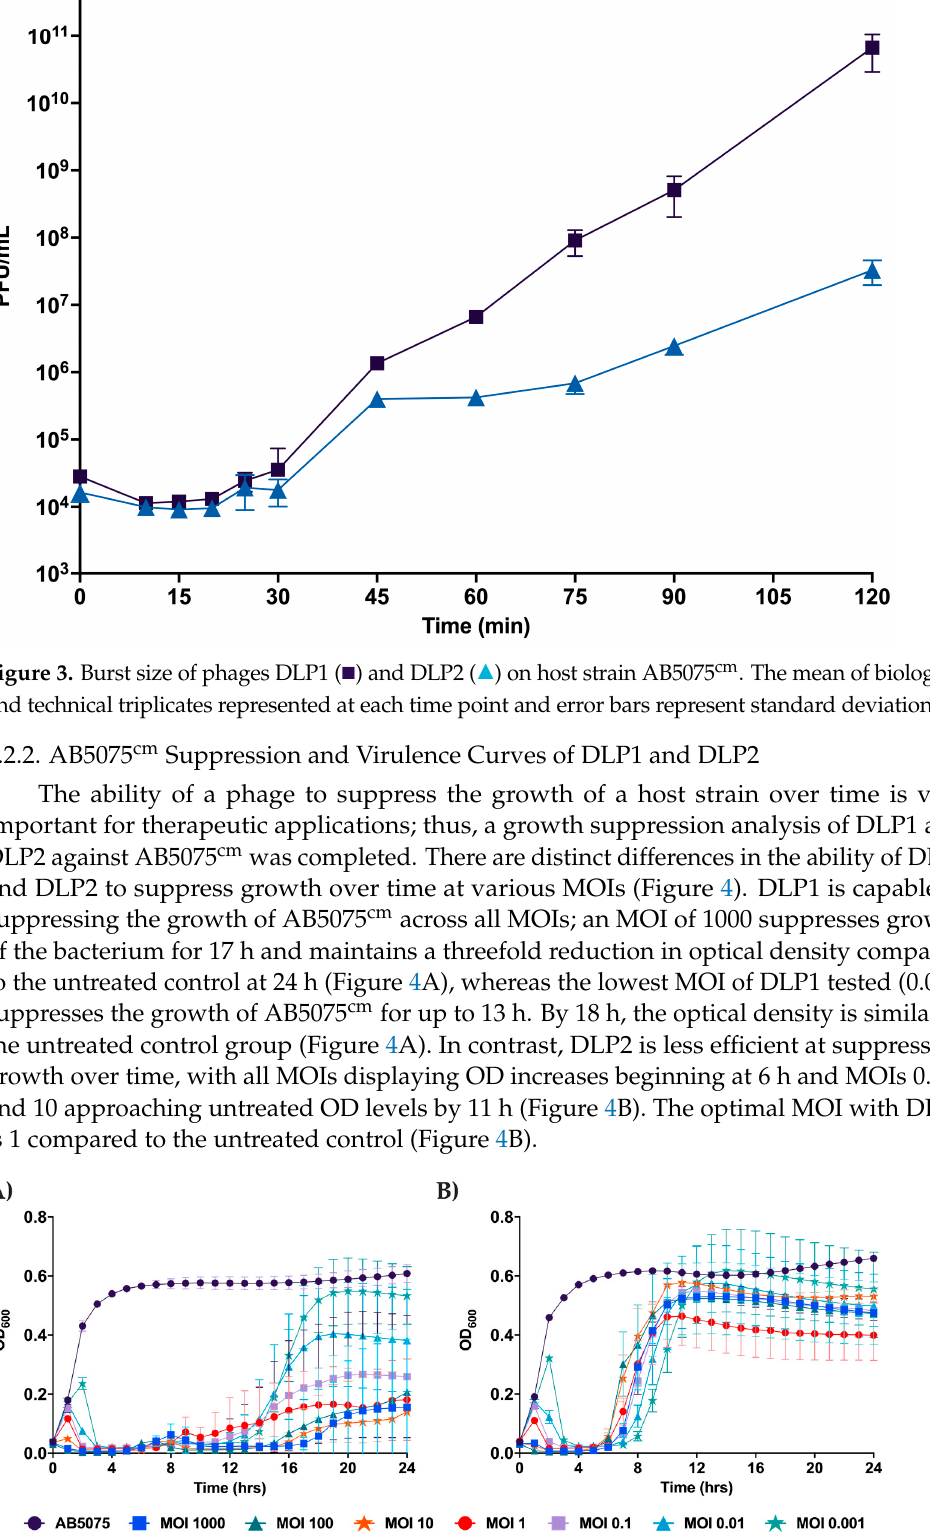
Figure 4. Growth suppression analysis of phages DLP1 ( A ) and DLP2 ( B ) against strain AB5075 cm over 24 h. The multiplicity of infection (MOI) range was studied from 0.001 to 1000 for each phage. The mean and standard deviation are represented from three biological and technical triplicate experiments.